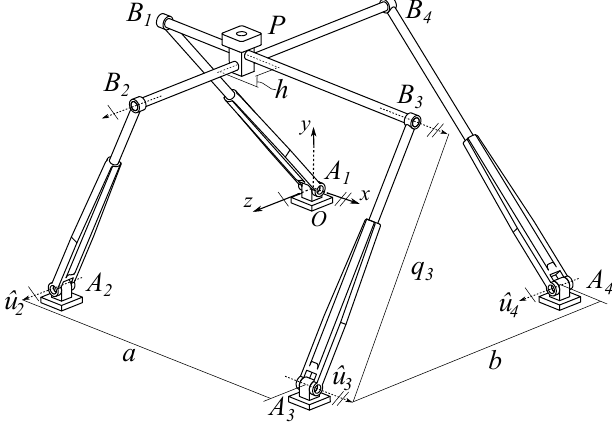
Figure 1. Proposed parallel robot.